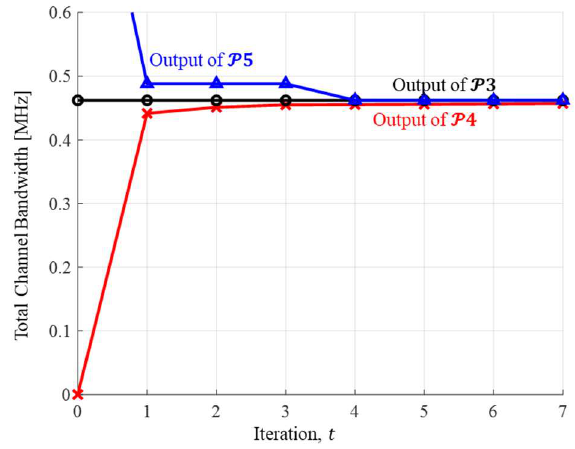
Figure 4. Snapshot of the iterative operation of the proposed channel assignment algorithm .